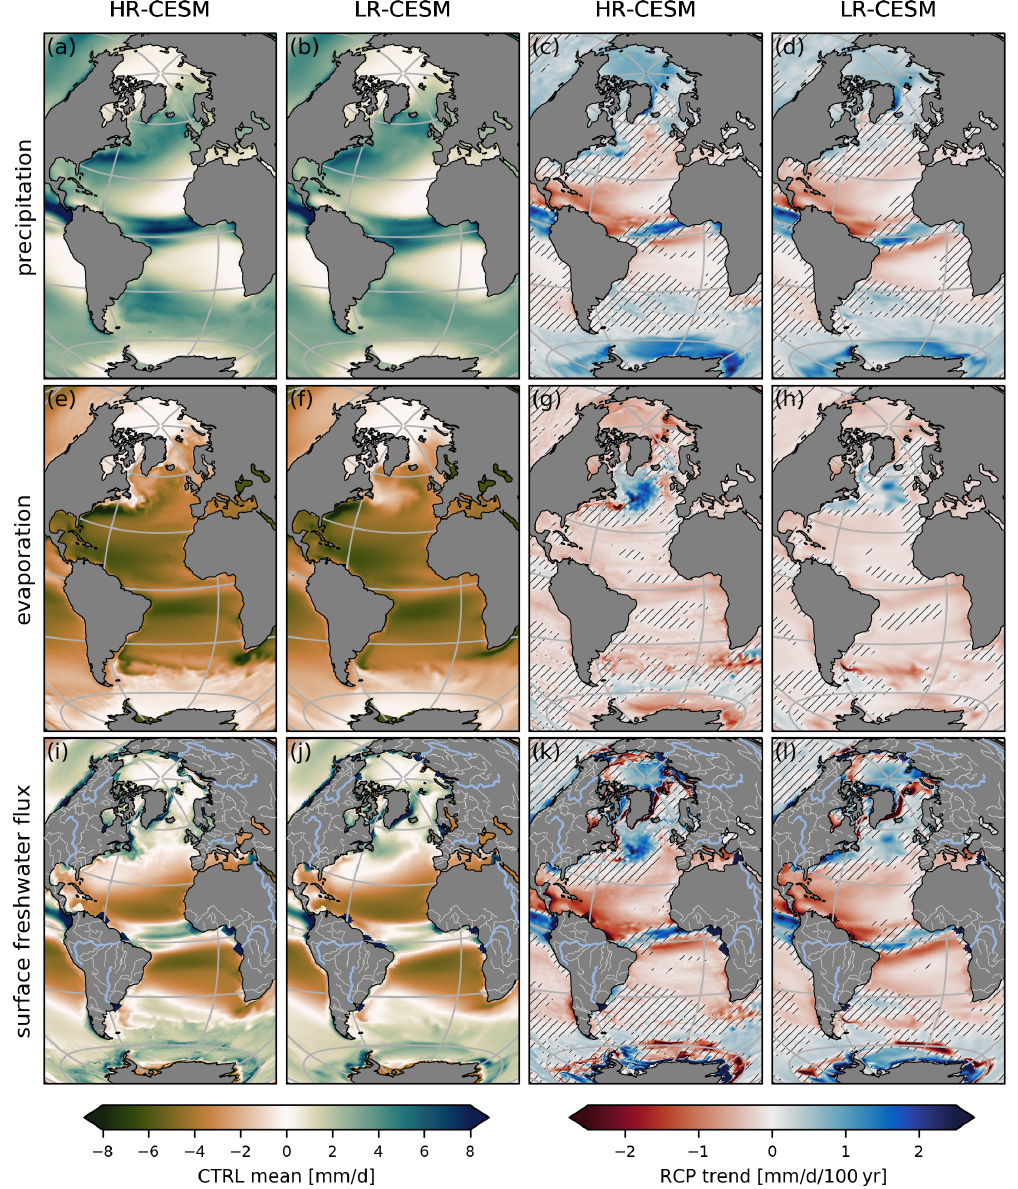
Figure 6. The major freshwater flux components, precipitation P (a–d) and evaporation E (e–h) , and the total freshwater flux F surf (i–l) . The means of the HR-CESM (a, e, i) and LR-CESM (b, f, j) CTRL simulations and the linear trends of the HR-CESM (c, g, k) and LR-CESM (d, h, l) RCP simulations. Polygons near river mouths in panels (i) – (l) are areas where runoff is distributed by the ocean model. Hatched areas in the trend maps are not significant at the 5%